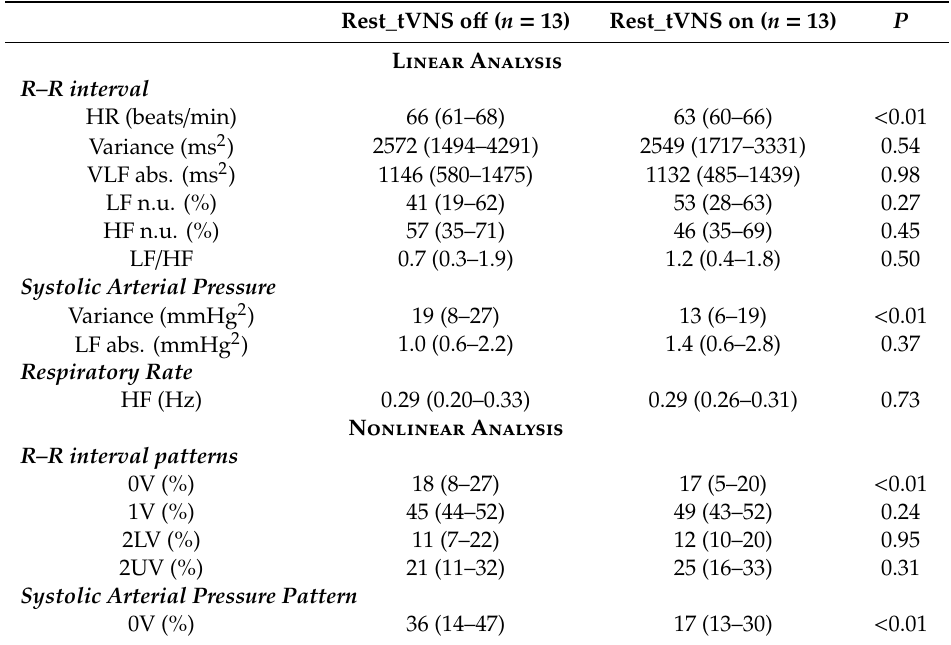
Table 2. Baseline measures of cardiac and peripheral autonomic control evaluated by linear and nonlinear approaches.